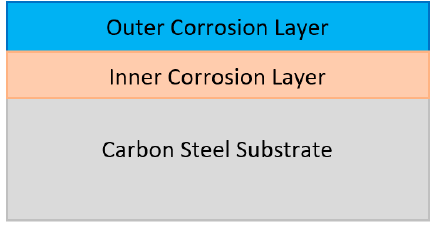
Figure 9. Schematic of formed corrosion products.